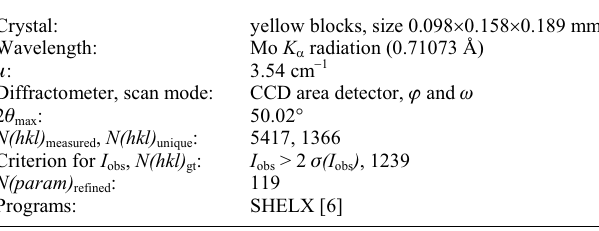
Table 1. Data collection and handling.